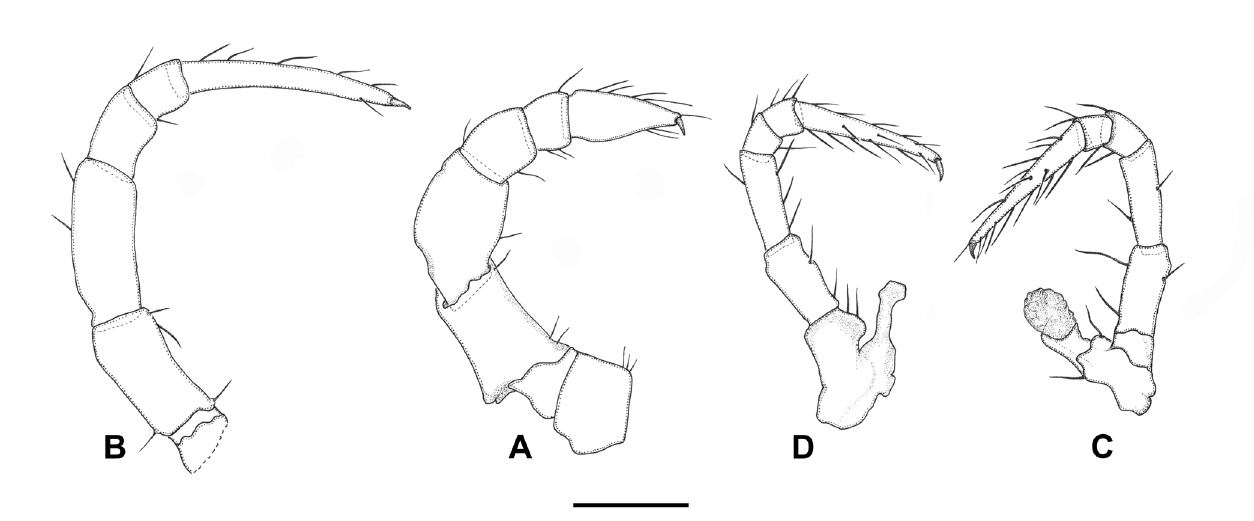
Fig. 5. Legs of Anamastigona strasseri sp. nov., ♂, holotype. A . Leg 4. B . Leg 7. C . Leg 10. D . Leg 11. Scale bar =